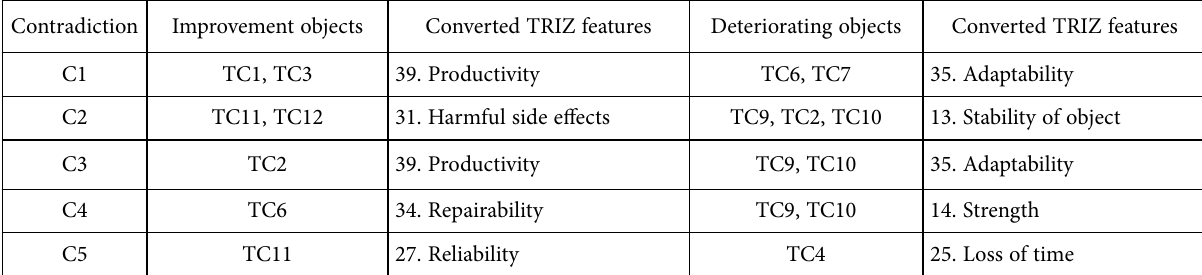
Table 6. Conversion of the improvement objects into TRIZ standard features